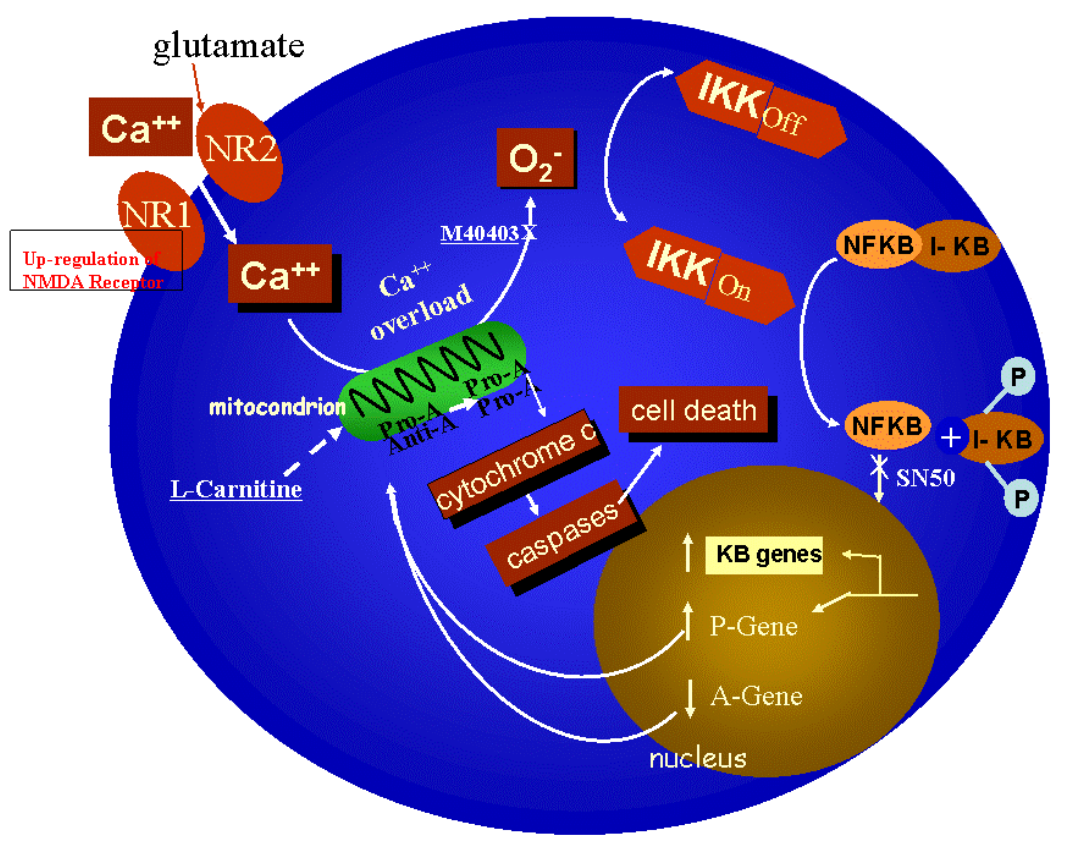
FIGURE 3. The cartoon illustrating the working model of anesthetic-induced (e.g., ketamine) neuronal cell death and potential protection mechanisms.